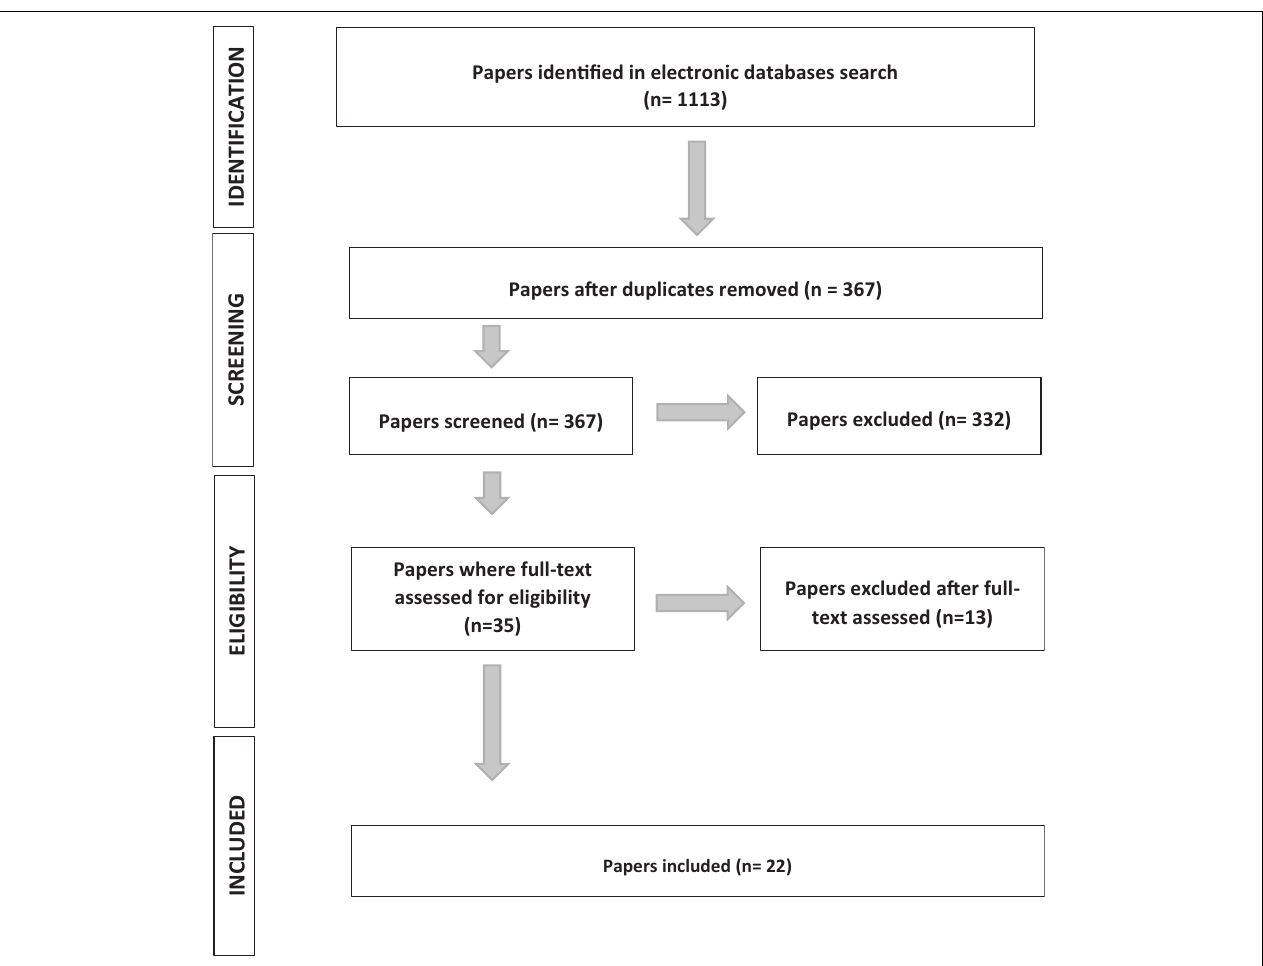
FIGURE 1 | Flowchart of the search process. Numbers show how many studies were included at each stage.